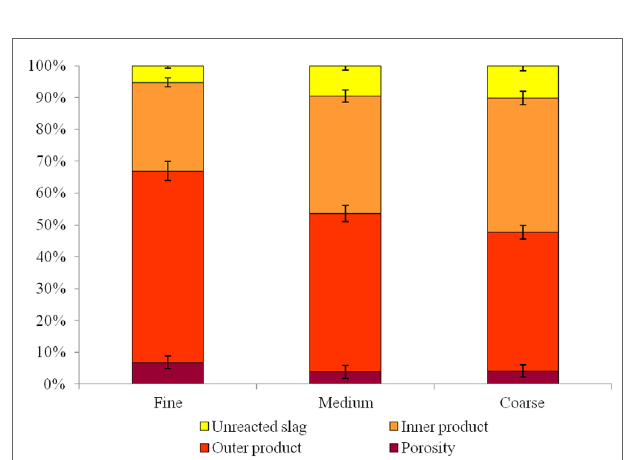
FigUre 8 | atomic ratios na/si and ca/si, as a function of the distance from the interface between paste and aggregate, in the low-alkalinity alkali-activated slag mortar, for each sand type: (a) coarse sand, (B) medium sand, and (c) fine sand